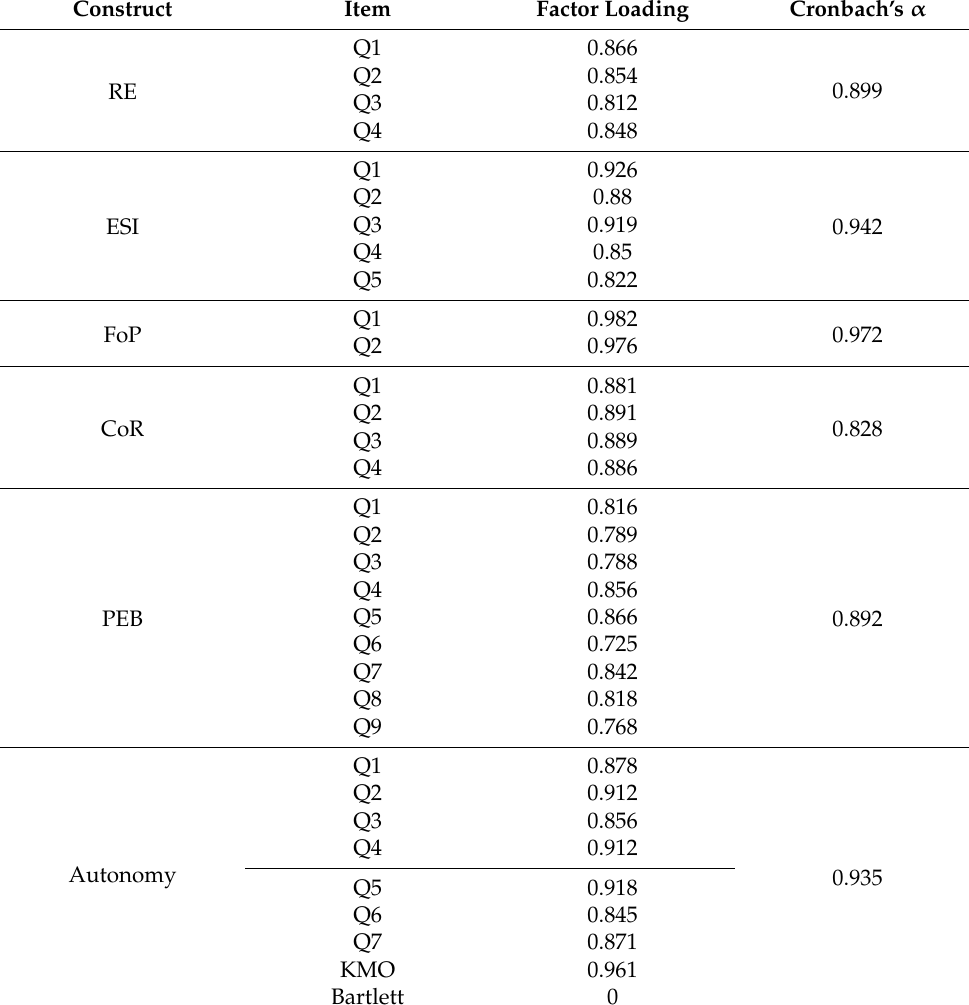
Table 1. Constructs and measurement.